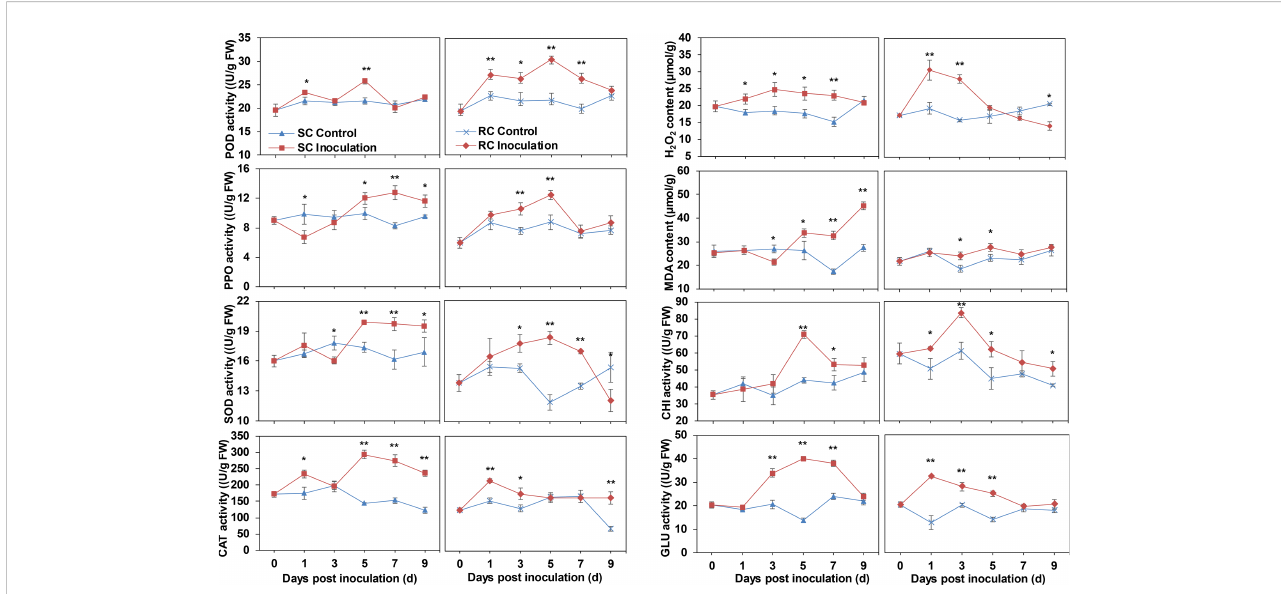
FIGURE 2 Determination of physiological indexes related to disease resistance, including peroxidase (POD), polyphenol oxidase (PPO), superoxide dismutase (SOD), catalase (CAT) enzyme activity, hydrogen peroxide (H 2 O 2 ) and malondialdehyde (MDA) content, chitinase (CHI) and b -1,3 glucanase (GLU) enzyme activity. Error bars represent standard deviation (n = 3). * indicates a signi fi cant difference at p-value < 0.05, ** indicates a signi fi cant difference at p-value <